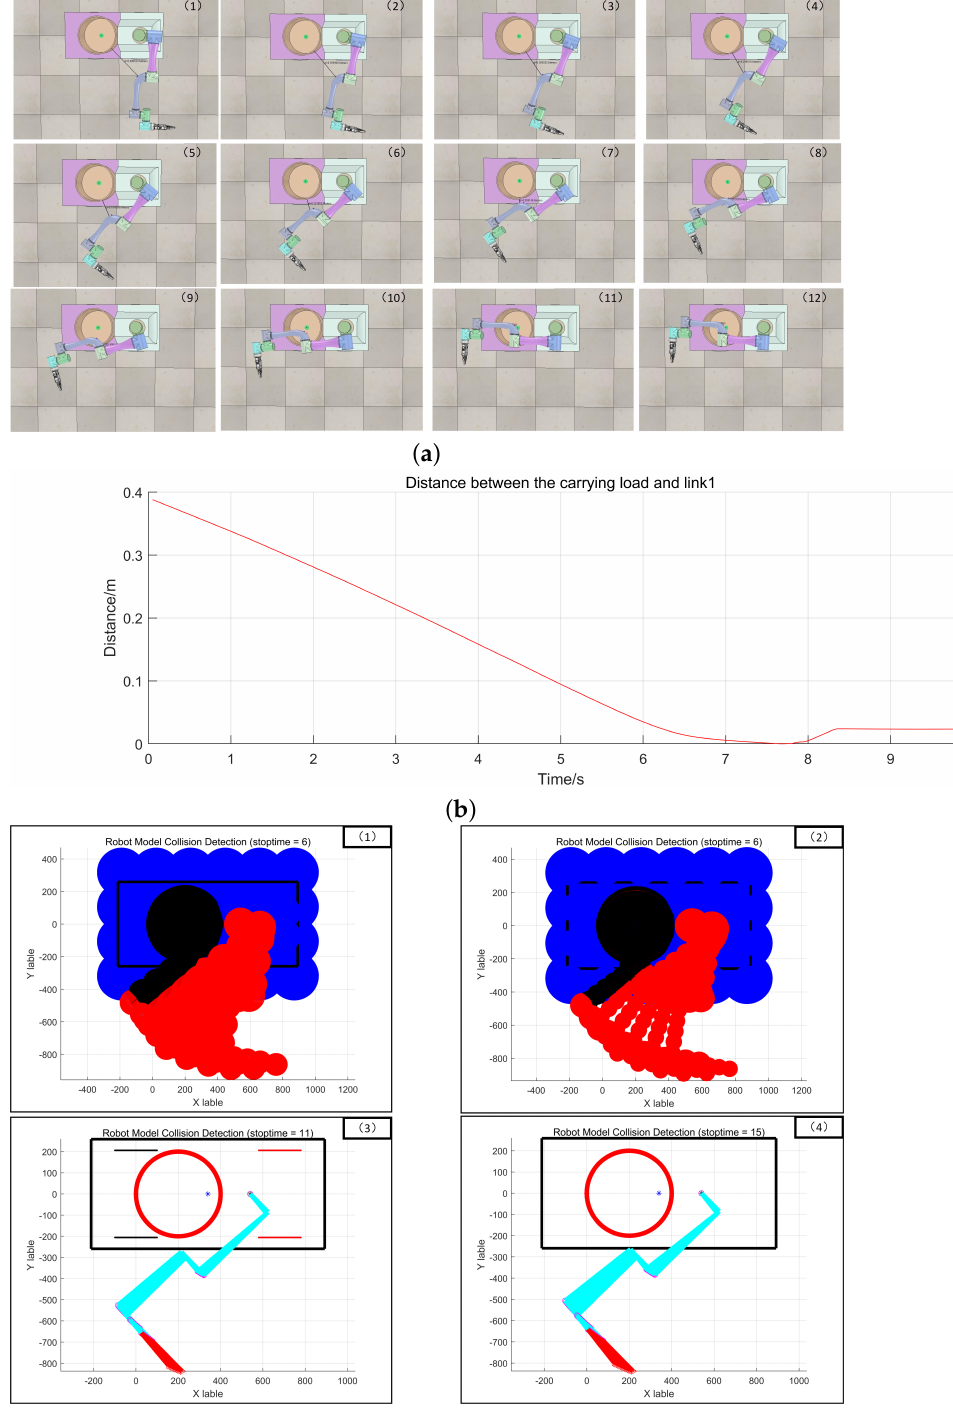
Figure 10. Detection of self-collision between different components of the manipulator subsystem. ( a ) The movement of the mobile manipulator in situation 2 based on the VREP software; ( a1 – a9 ) The movement of the mobile manipulator before reaching collision location in situation 1 based on the VREP software; ( a10 – a12 ) The movement of the mobile manipulator after reaching collision location in situation 1 based on the VREP software; ( b ) Distance changes between the carrying load and the manipulator subsystem; ( c1 ) Detection of self-collision using the typical method; ( c2 ) Detection of self-collision using the improved method; ( c3 ) Simplify the detection of self-collision using the typical method; ( c4 ) Simplify the detection of self-collision using the improved